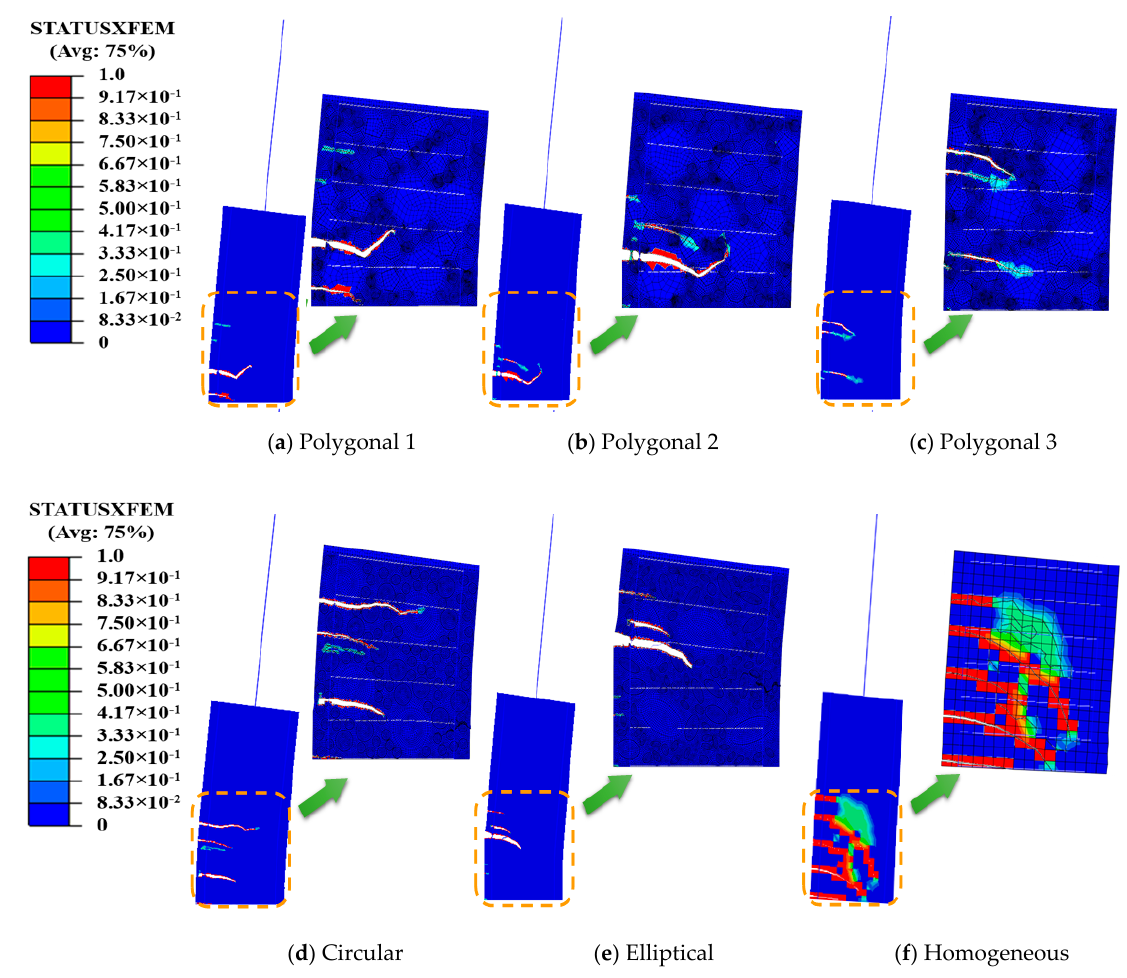
Figure 16. Crack pattern in XFEM ‐ based multiscale models.